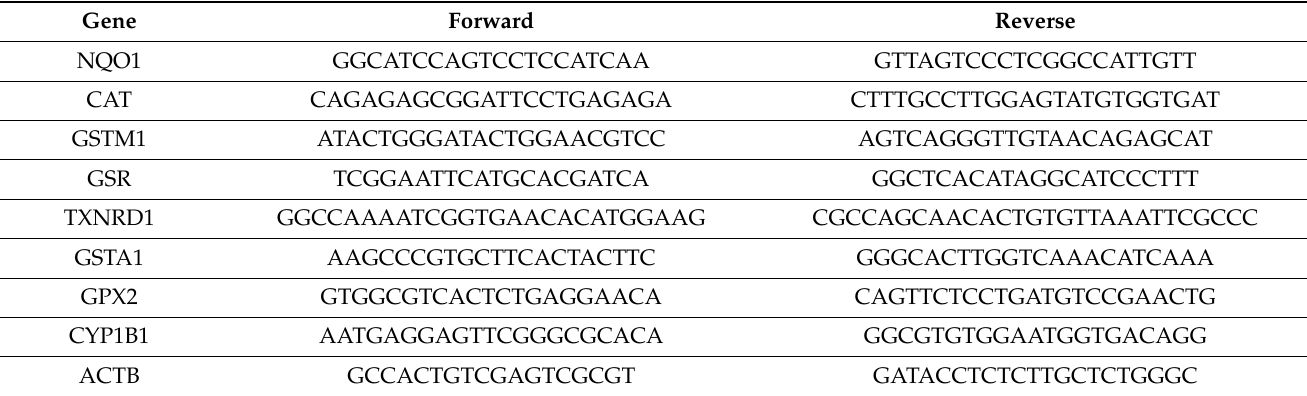
Table 1. List of primers used for